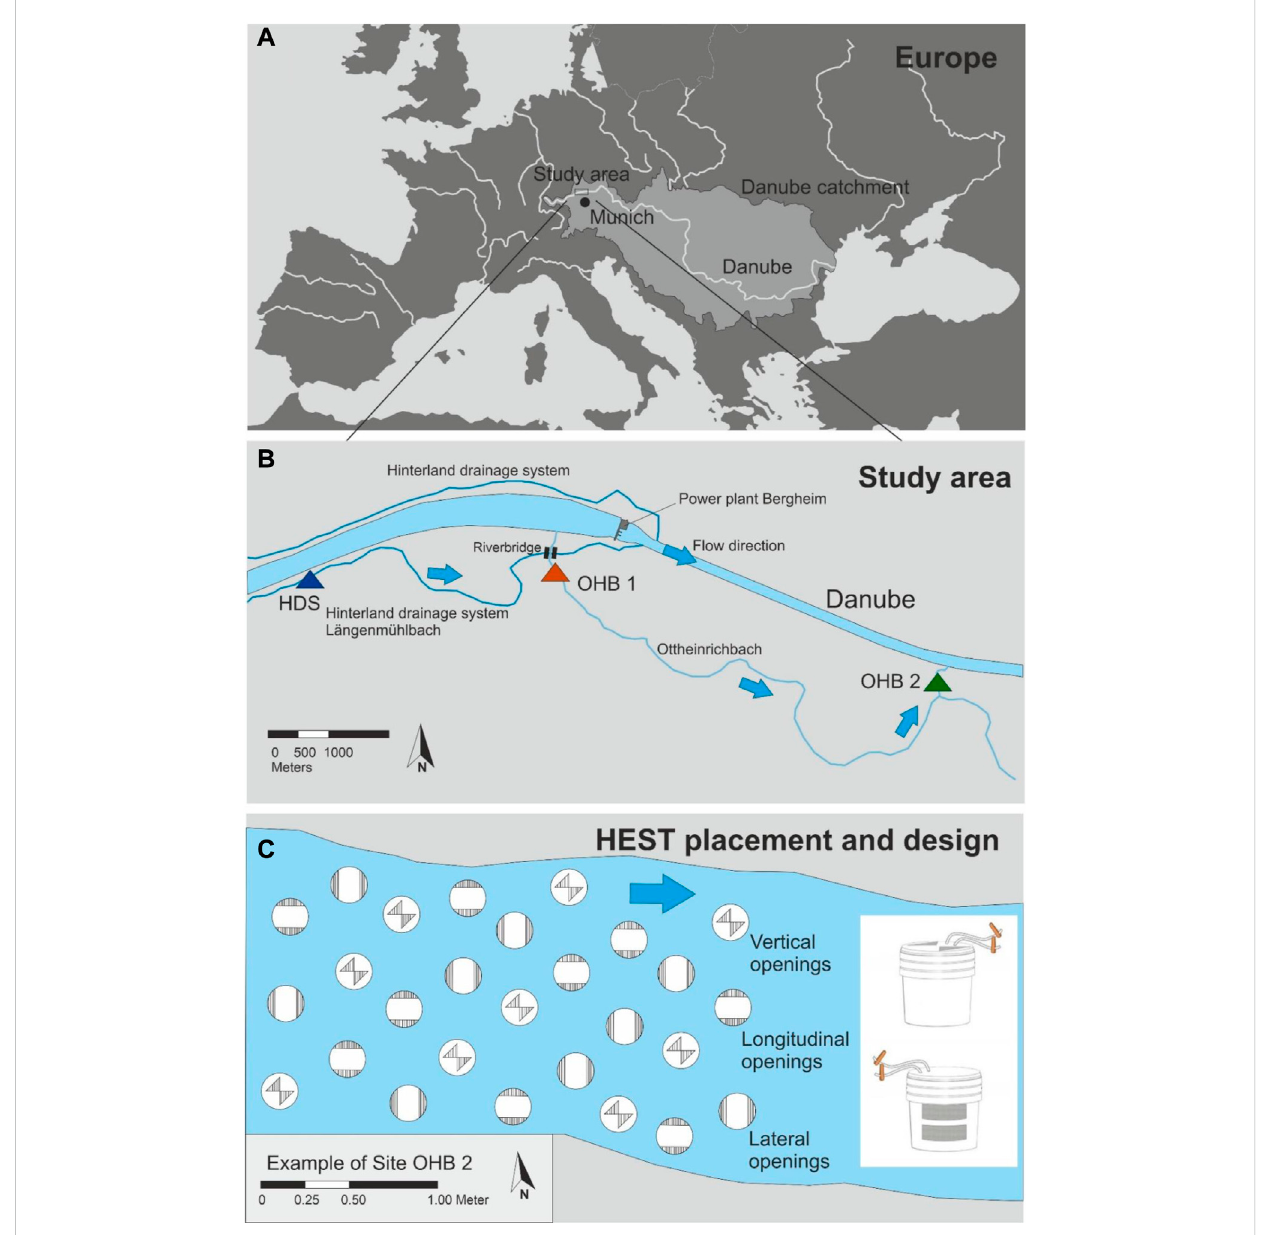
FIGURE 2 Illustration of the study area within Europe (A) and location of the three investigated spawning grounds (B) , one in the hinterland draining system Längenmühlbach (HDS) and two in the Ottheinrichbach (OHB 1 and OHB 2) within a large scale fl oodplain restoration at the Danube river. Colored triangles indicate the location of the three assessed spawning grounds; blue arrows indicate the fl ow directions. The lowermost Panel (C) indicates placement and construction of the HydroEcoSedimentary Tool (HEST) in OHB 2 as an